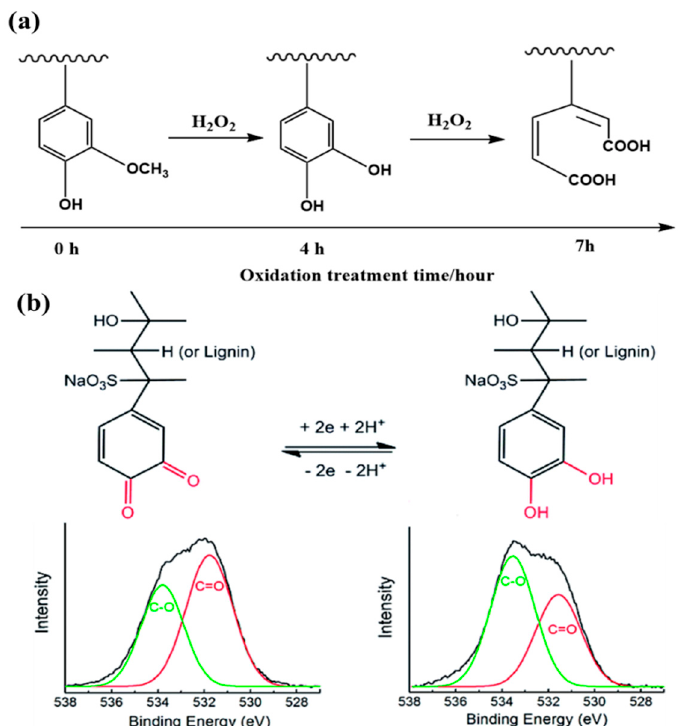
Figure 4. ( a ) Changes in the functional groups in KL upon oxidation. Reprinted with permission from Ref. [35]. Copyright 2020 John Wiley & Sons. ( b ) Mechanism of redox transfer of the Q/QH 2 structure during the charge/discharge process. High-resolution O 1s XPS spectra of the LS-GH (left) before and (right) after charging. Reprinted with permission from Ref. [34]. Copyright 2017 Royal Society of Chemistry.